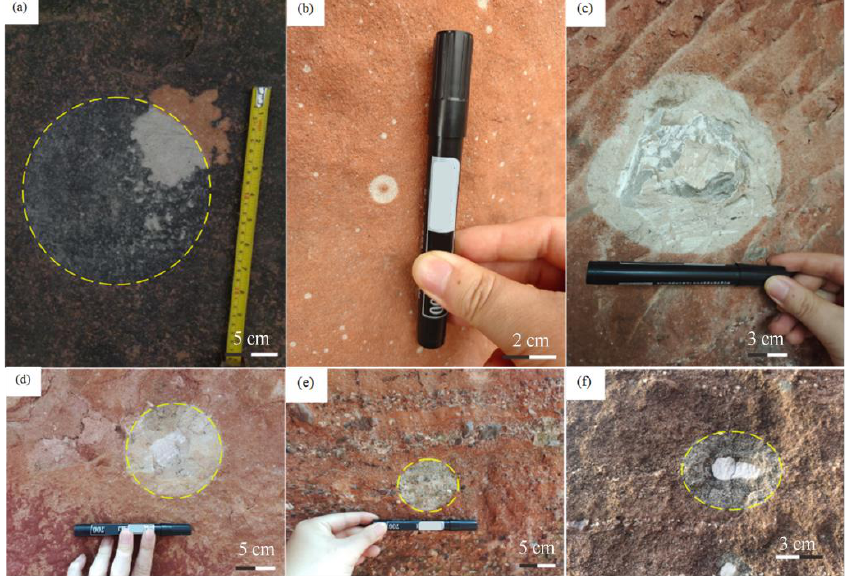
Figure 3. ( a ) A large perfectly round white reduction spot in reddish-brown sandstone; ( b ) many reduction spots of different sizes in reddish-brown sandstone (note red core exists at center of a white reduction spot); ( c ) reduction ring around carbonate fragments in red sandstone; ( d ) sub-circular gray-white reduced spot in the red bed; ( e ) sub-elliptical light green reduction spot in red conglomerate (note its long axis is parallel to bedding); ( f ) gravelly debris in center of sub-elliptical reduction spot and crossed by late-forming fractures. Reduction spot photo from Danxia Mountain, Guangdong, China.